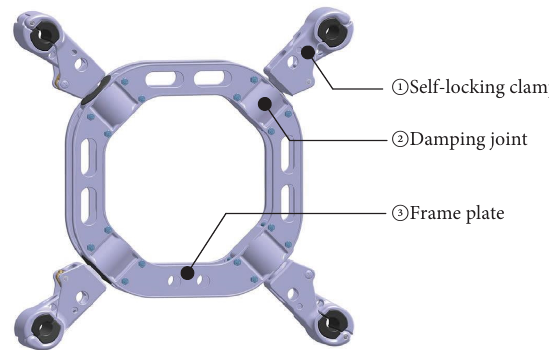
Figure 4: Structure of the new type of the quad-bundle spacer damper.